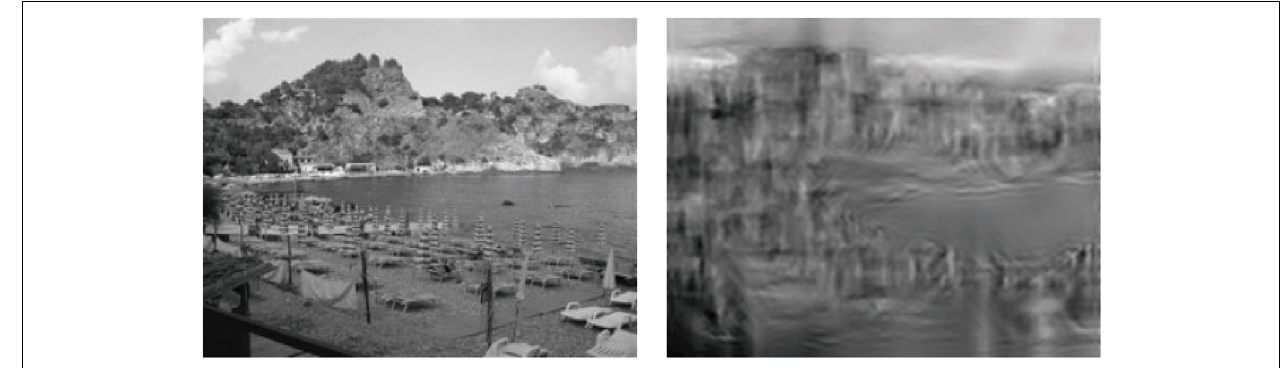
FIGURE 3 | Illustration of a natural scene (left) and its scene gist (right), generated by an image processing algorithm, that conserves sufficient spatial perceptual dimensions to infer the category of the scene (Figure reproduced from Oliva, 2005, Figure 41.3).